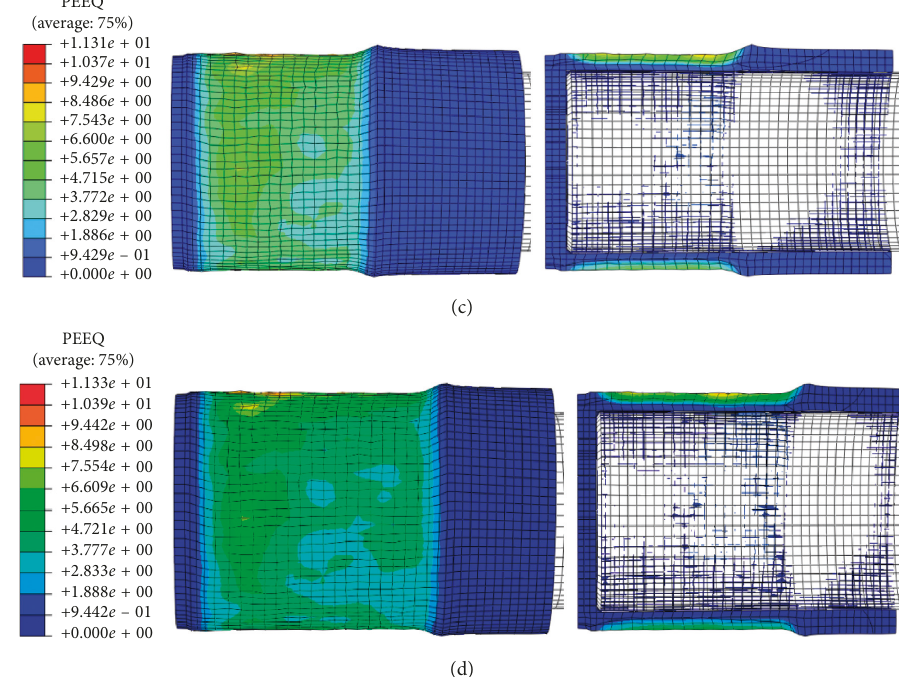
Figure 10: Second-pass equivalent strain distribution. (a) 25%. (b) 50%. (c) 75%. (d)